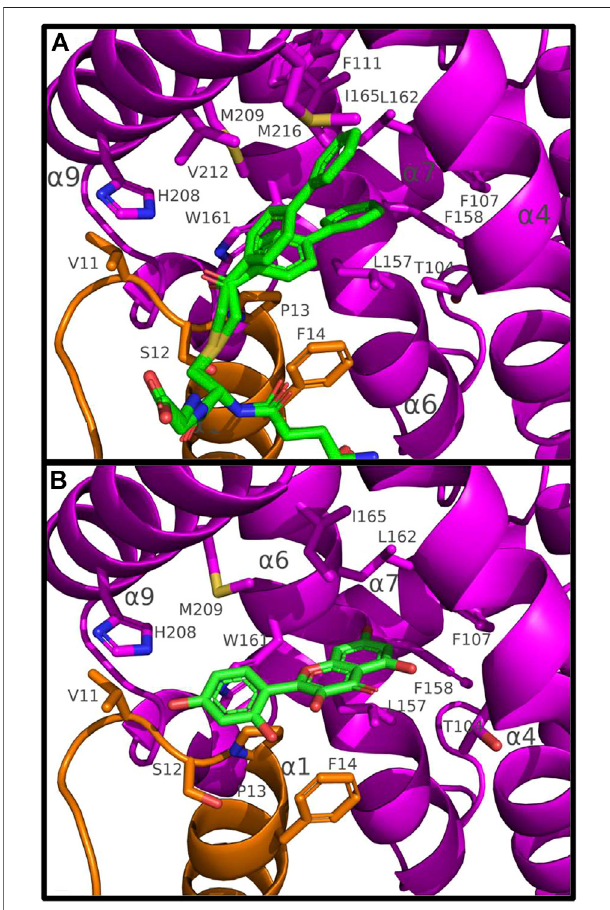
FIGURE3| BindingofGS-PAP (A) andmorin (B) intheputativeH-siteof PtGSTU20. Putative H-site of PtGSTU20 is a well-delineated cavity deeply inserted between the α 4 and α 6 helices of the C-terminal domain. Both conformations of GS-PAP are shown. The GS-PAP (A) and morin (B) ligands are represented in sticks as their surrounding residues. Intermolecular contacts arematerialized asdashed lines.The N- and C-terminaldomains are colored orange and magenta, respectively, and ligands are colored green. Non-carbon atoms are colored according to their types (red, oxygen; blue, nitrogen; yellow,